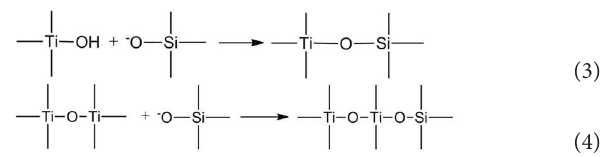
molecules can form a molecular network of titanium oxide, which can be expressed by Equation